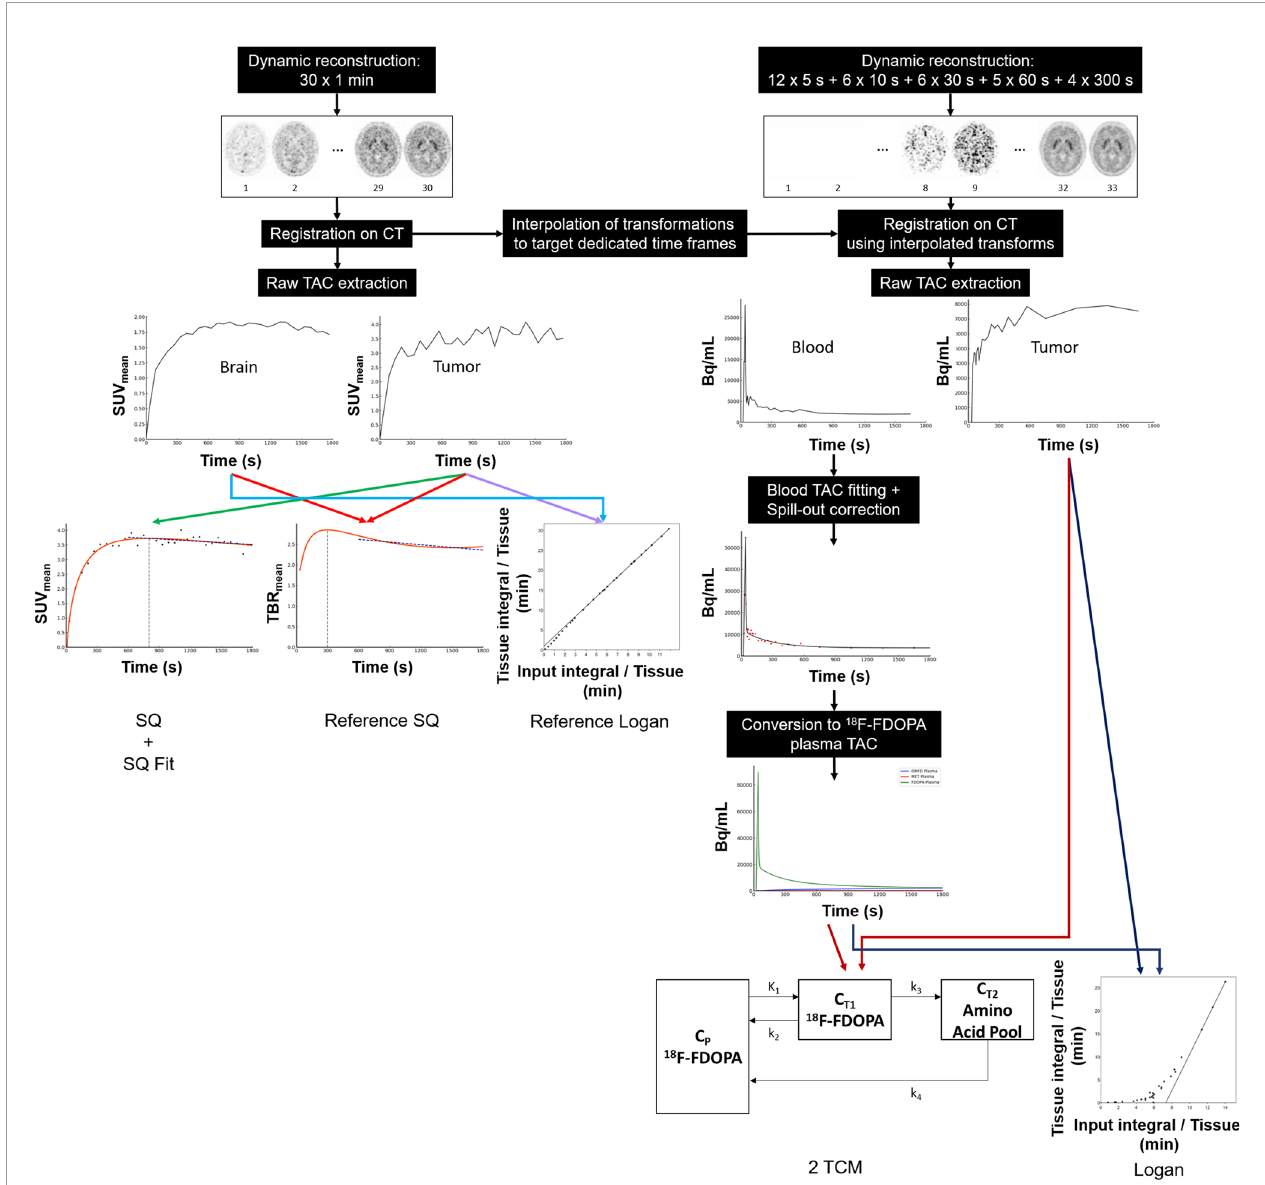
FIGURE 1 | Work fl ow showing the pre-processing steps required to perform dynamic analyses for all of the dynamic models used in this study: semiquantitative model ( SQ ) semiquantitative fi tting parameters ( SQ Fit ), reference semiquantitative model ( Reference SQ ), Logan model with input function ( Logan ), Logan model with reference region ( Reference Logan ), and the two-tissue compartmental model (2TCM). TBR , tumor-to-brain